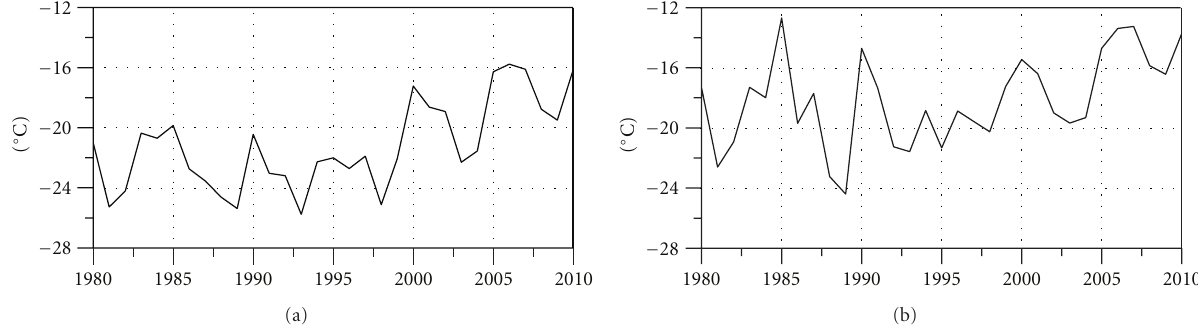
Figure 9: Air temperature at the surface in winter around Franz Joseph Land (a) and north of Svalbard (b).